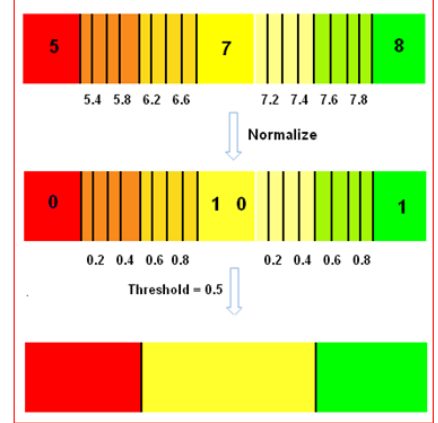
Figure 16. Universal threshold composition.